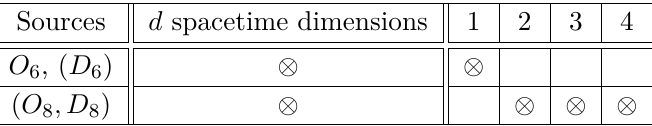
Table 1 . Supersymmetry-preserving source configuration allowing for possible de Sitter solutions in type IIA in d = 6